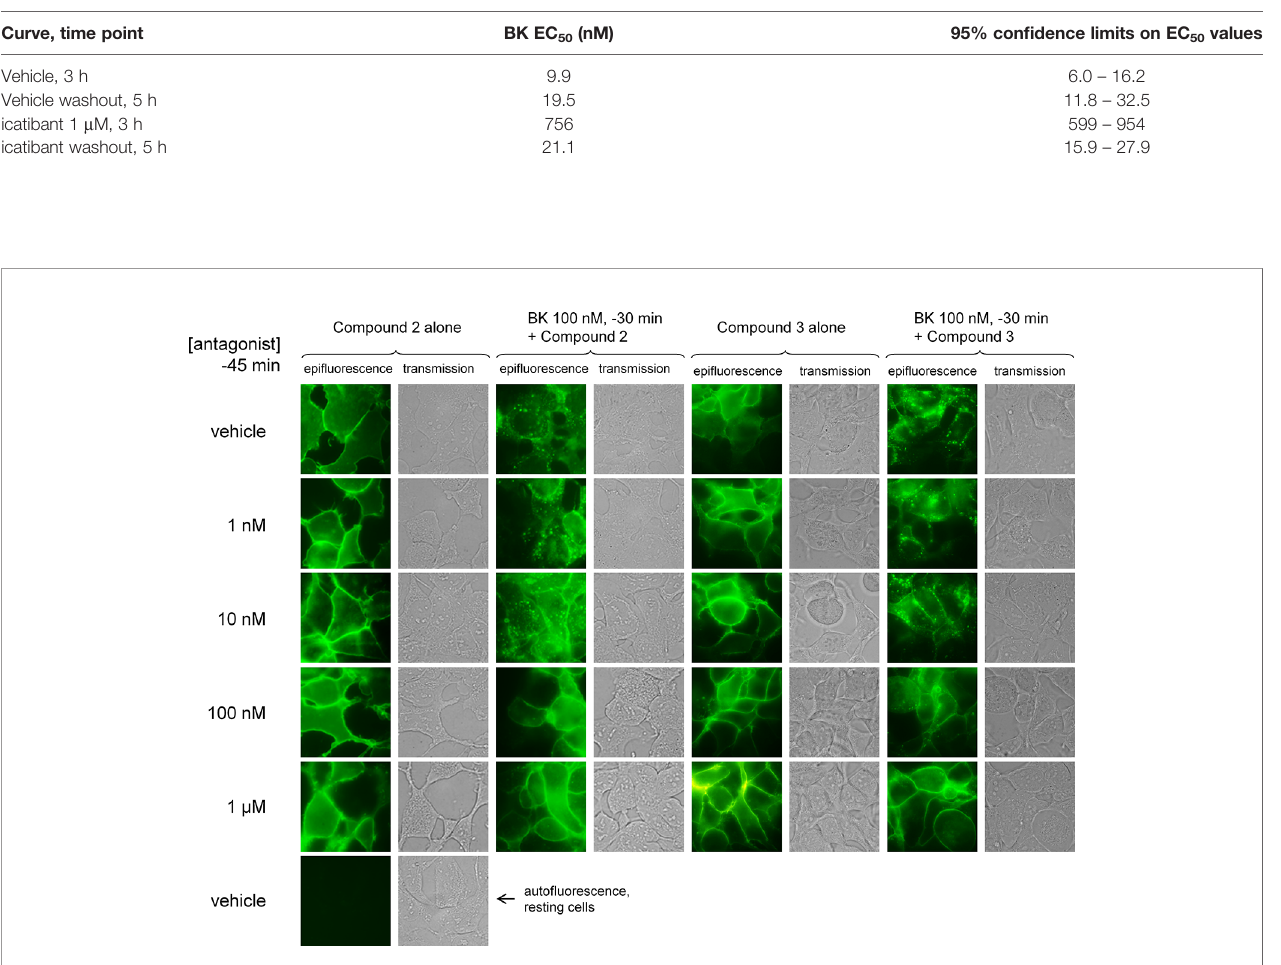
FIGURE 7 | Endocytosis of the fl uorescent anti-myc 4A6 monoclonal antibody by intact HEK 293a cells expressing myc-tagged human B 2 receptors (h myc-B2) treated as indicated at 37°C (BK 0 or 100 nM, the antagonists Compound 2 or Compound 3 at the indicated concentrations 15 min before). The intact cells had been labeled with the anti-myc tag antibodies prior to stimulation (see Methods ). Each fi eld is shown as a pair of images: epi fl uorescence in intact cells (left); transmission (right). Original magni fi cation 1,000 ×; the sides of each square fi eld are 120 µm long. Cells incubated without the antibody were photographed using the same settings to evaluate the auto fl